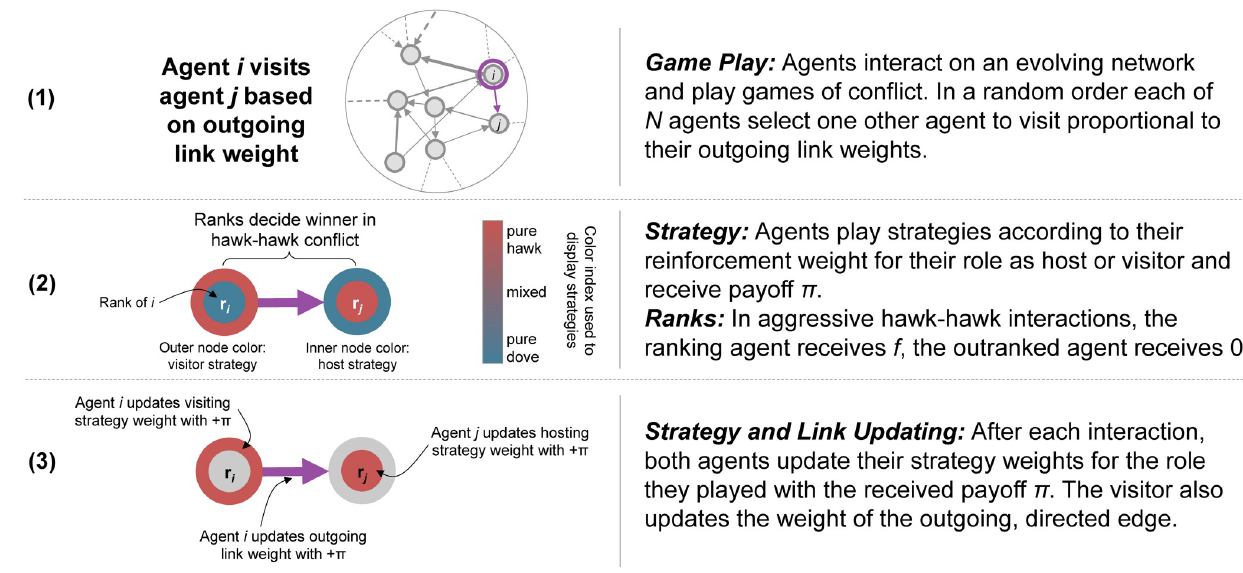
Fig 1. Game play and updating mechanism. In each round agents must (1) select an interaction partner, (2) play a game of conflict, and (3) update both their network weight and strategy weights based on the payoff π .